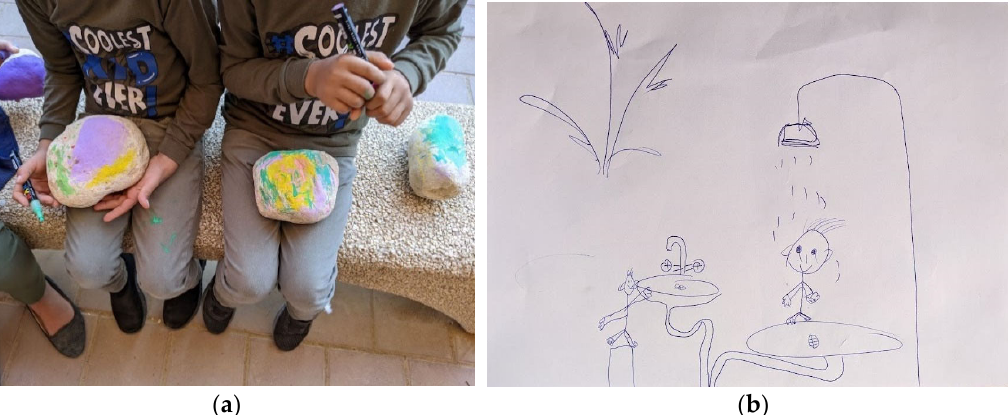
Figure 16. The local products of the Creative Workshops at the “Desert Sustainability and Art” Festival, Kuseife, 2021. ( a ) Children holding their Stone Painting Workshop products and ( b ) Children’s drawing reflecting the water problem from their eyes, and their creative water harvesting solutions Photographed by Dan Farberoff. Images courtesy of the artist.